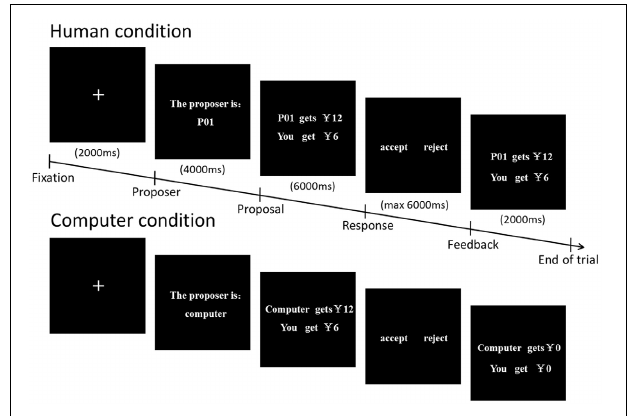
FIGURE 1 | Diagram illustrating the structure of a single round of the ultimatum